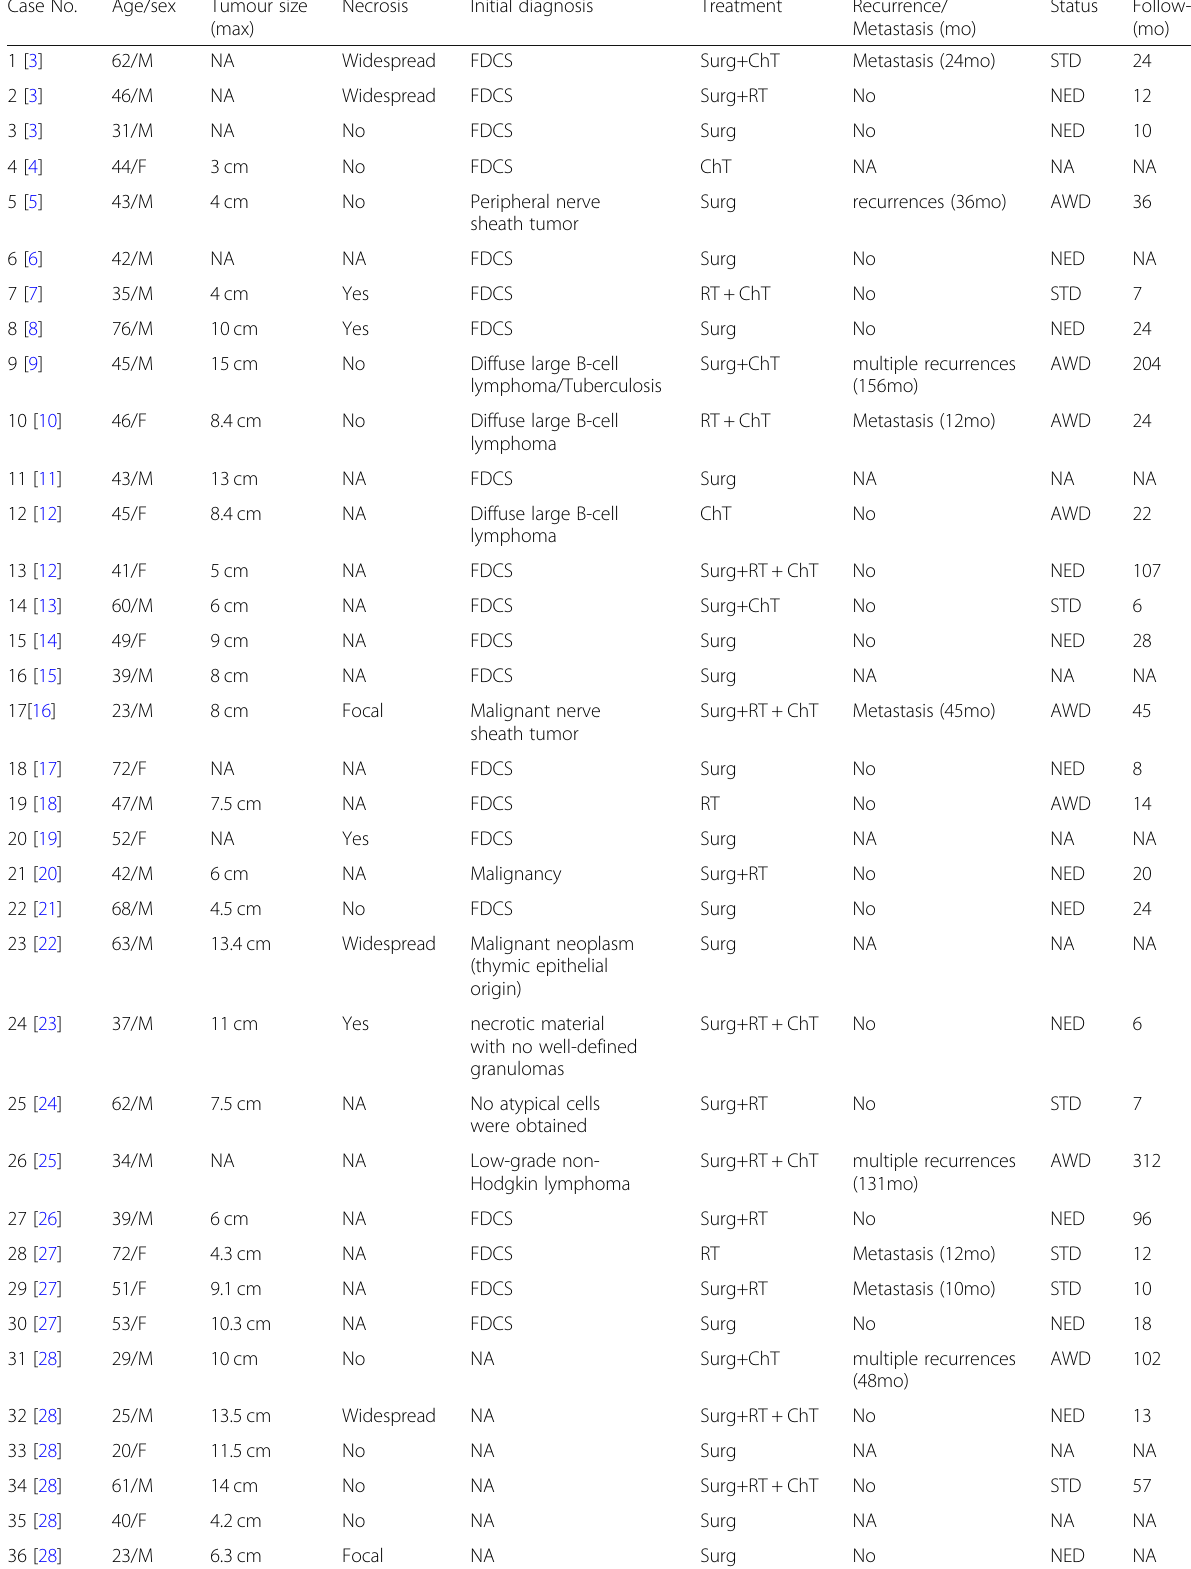
Table 2 Summaries of 43 cases of mediastinal follicular dendritic cell sarcomas Case